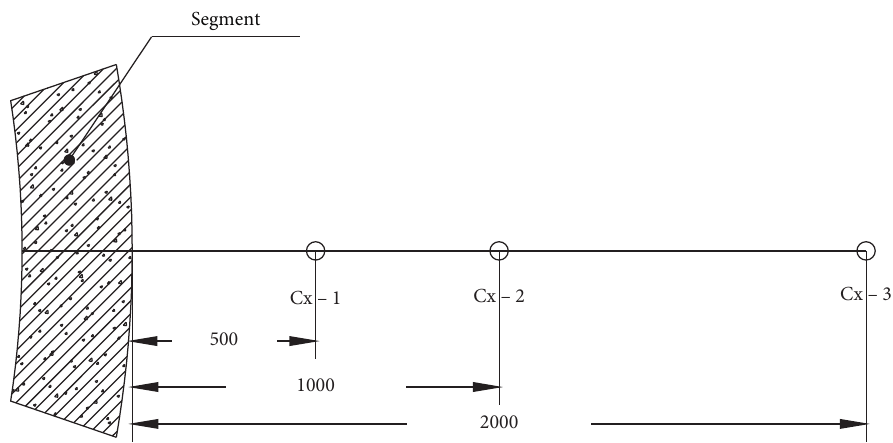
Figure 3: Layout of the temperature-measuring points (unit: